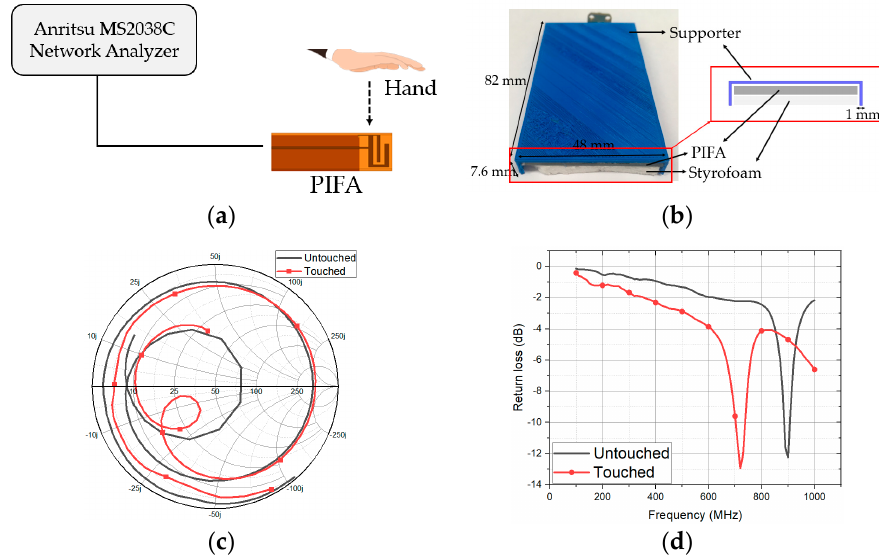
Figure 2. ( a ) Measurement setup of PIFA at touched and untouched states; ( b ) Photograph of the 3D printed mockup with PIFA; ( c ) measured input impedances on Smith Chart at touched and untouched states; ( d ) measured reflection coefficients at touched and untouched